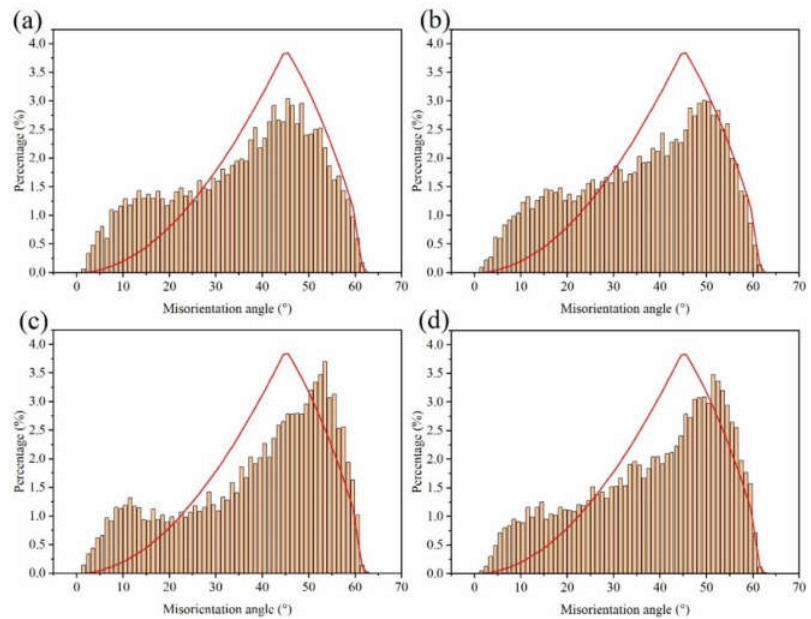
Figure 6. Distribution of the boundary misorientation angle at ( a ) DCT-0, ( b ) DCT-12, ( c ) DCT-24, and ( d ) DCT-48.